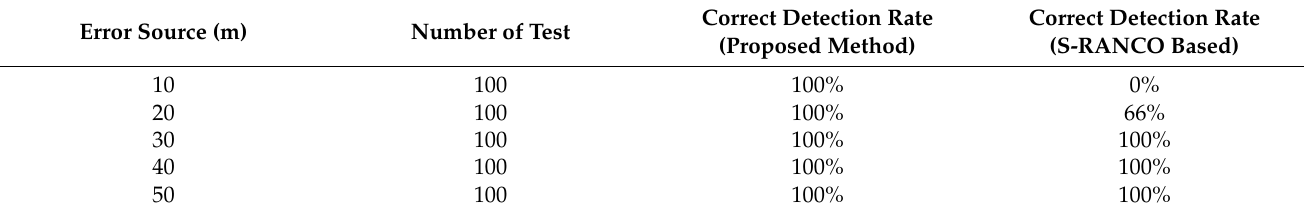
Table 2. Comparison of algorithms performance with various values of error sources in Scenario 1.